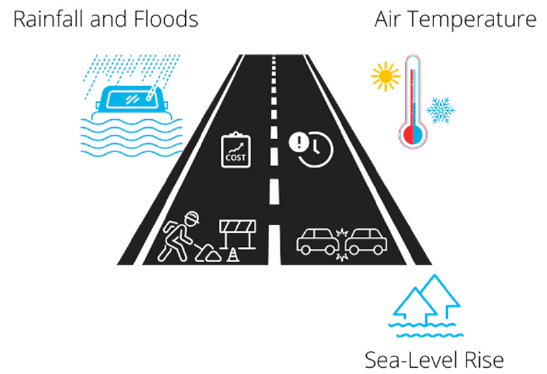
Figure 2. Climate change challenges.